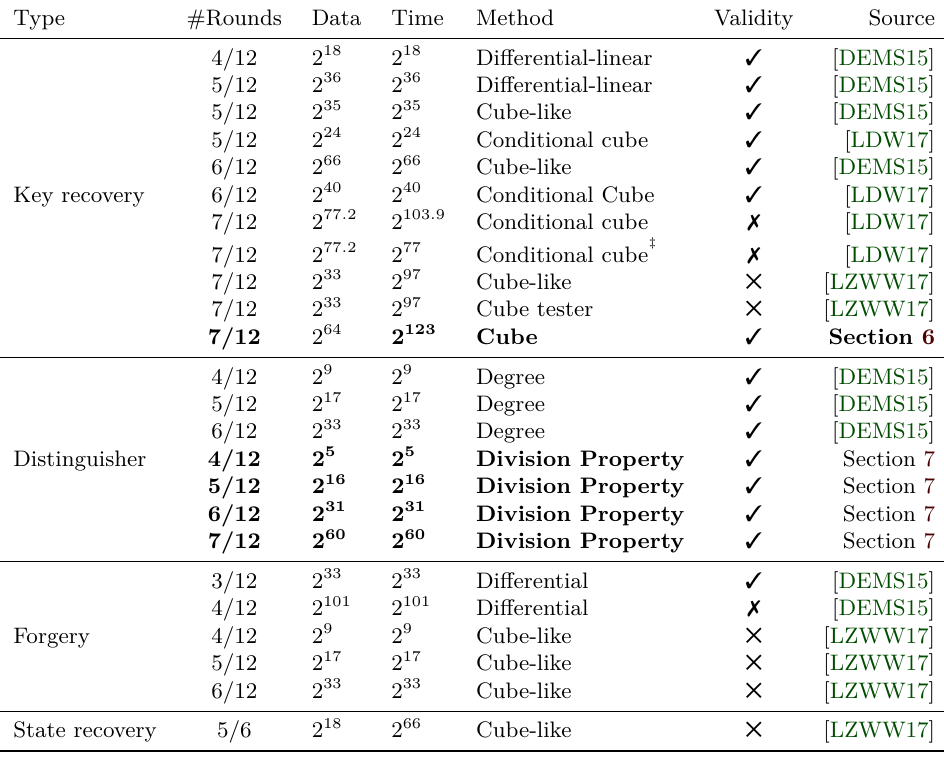
Table 1: Summary of attacks and distinguishers on Ascon in the AEAD